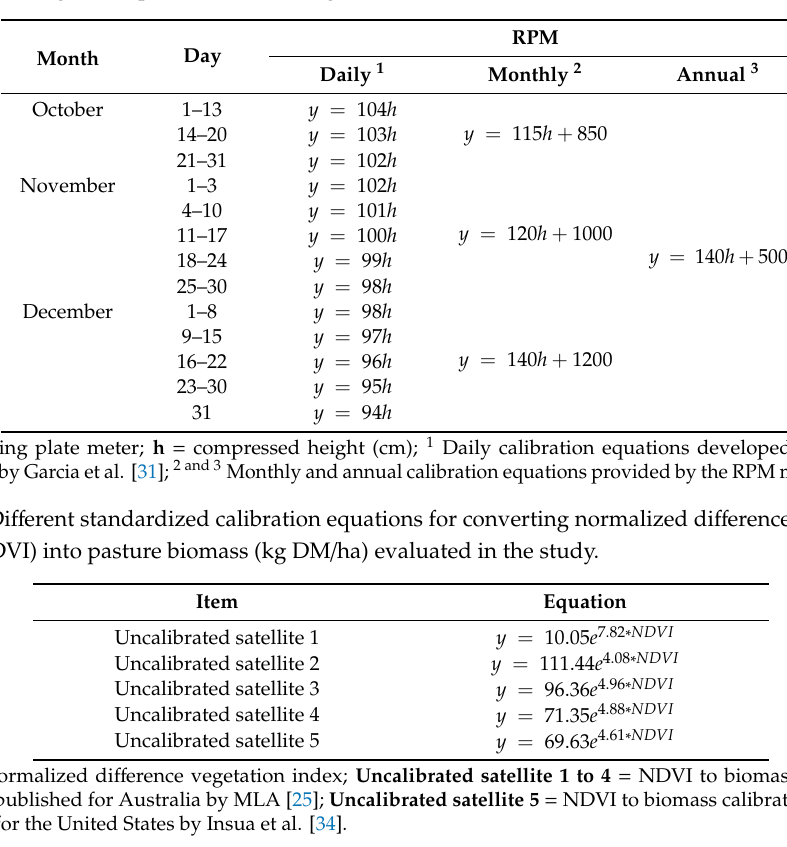
Table 2. Standardized calibration equations evaluated for converting rising plate meter (RPM) compressed height into pasture biomass (kg DM / ha).